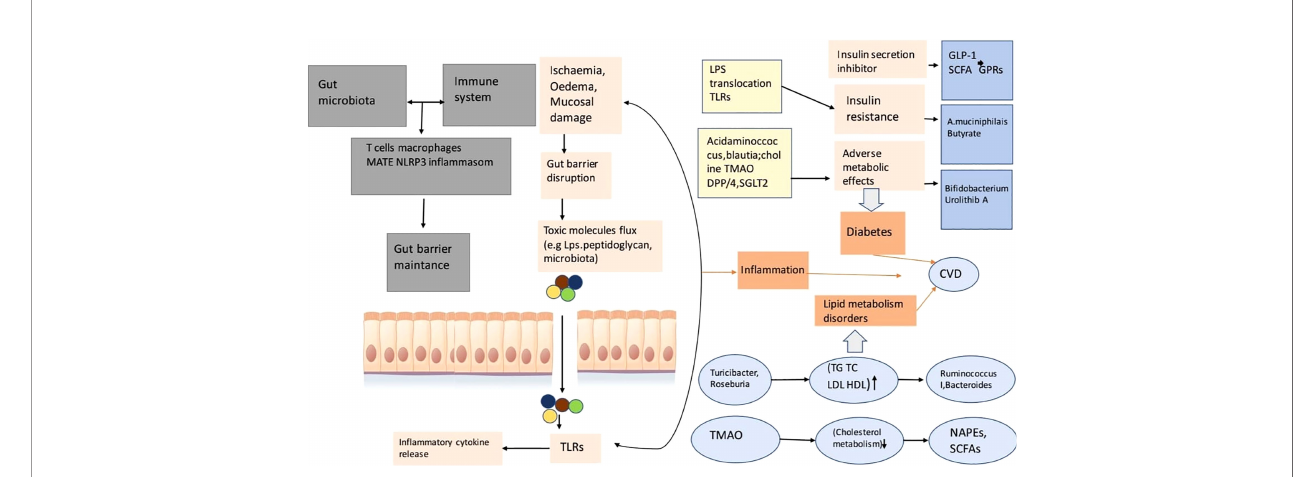
FIGURE 4 | This is a diagram of cardiovascular risk and related to in fl ammation, the disorder of lipid metabolizing, diabetes relation with gut microbial disease. This gut microbiota reacts with the immune system of the animal or human body so that it can take control of the function of the gut barrier. A porous barrier in fl uences the uprising of the fl ux of pro-in fl ammatory microorganisms (bacteria) into systemic circulation, thus the situation causes low-level in fl ammation through TLR activation (Xu et al.,